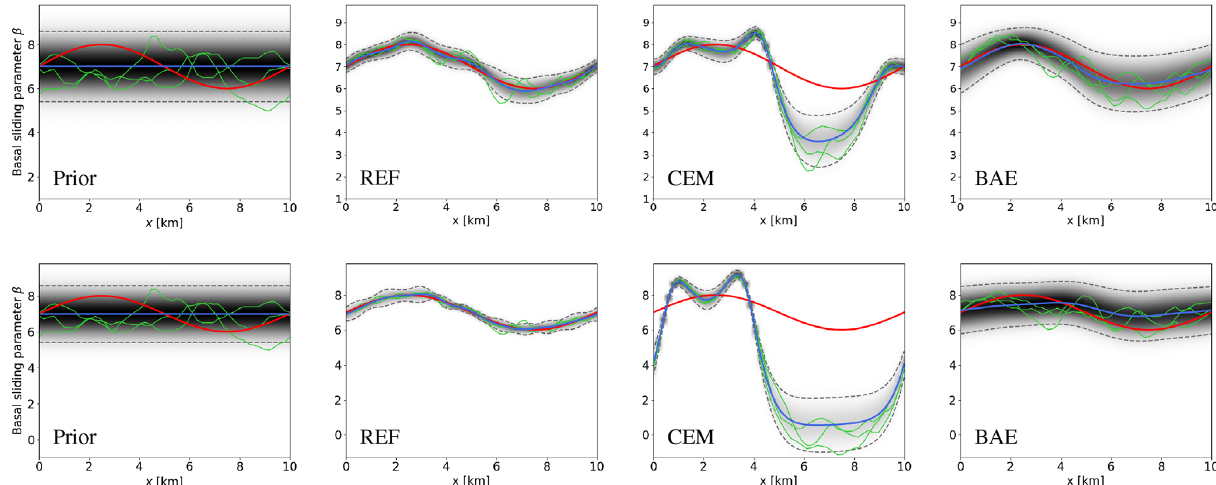
Figure 10. Prior and MAP estimates of the basal sliding parameter for Example 2. Top row: Example 2a prior (far left), accurate/reference (REF) case (center left), conventional error model (CEM) case (center right), and Bayesian approximation error (BAE) case (far right). The bottom row shows the same plots for Example 2b. In each plot, the mean of the distribution (blue line) is shown along with the true basal sliding parameter, β true (red line), three samples from the respective distributions (green lines), the marginal distribution (shaded) with darker shading indicating higher probability, and the ± 2 (approximate) standard deviation intervals (dashed black line).